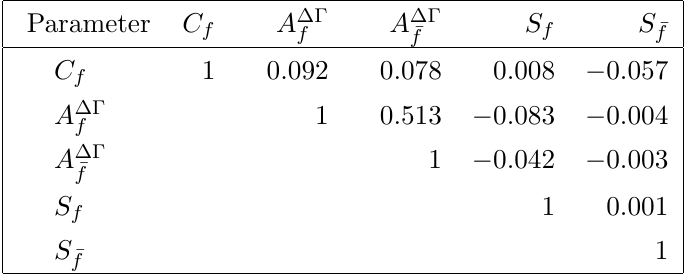
Table 3 . Values of the CP -violation parameters obtained from the (cid:12)t to the decay-time distribution K (cid:6) decays. The (cid:12)rst uncertainty is statistical and the second is systematic. of B 0 D (cid:7) s ! s